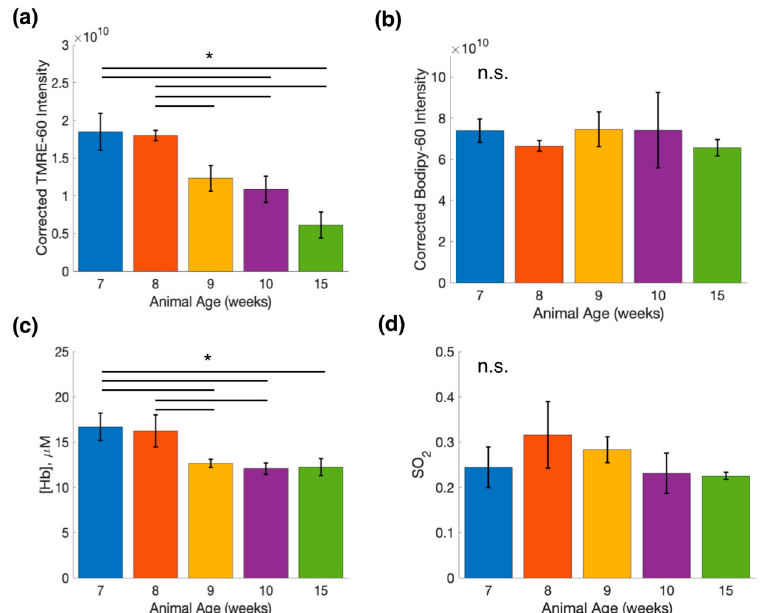
Figure 5. Bodipy FL C16-TMRE spectroscopy measurements reveal metabolic and vascular changes in normal mammary glands throughout development. ( a ) Comparison of mean TMRE fluorescence intensity for mammary tissue at different ages. ( b ) Comparison of mean Bodipy FL C16 fluorescence intensity for mammary tissue at different ages. ( c ) Comparison of total hemoglobin concentration ([Hb]) for mammary tissue at different ages. ( d ) Comparison of oxygen saturation ([SO 2 ]) for mammary tissue at different ages. Error bars represent the standard error (SE) of the mean along each axis. For each timepoint n = 5, except for weeks 8 and 15 where n = 4. Statistical analysis was performed using a Wilcoxon rank-sum test to compare means. * Is p < 0.05 for all comparisons. n.s. is not significant.